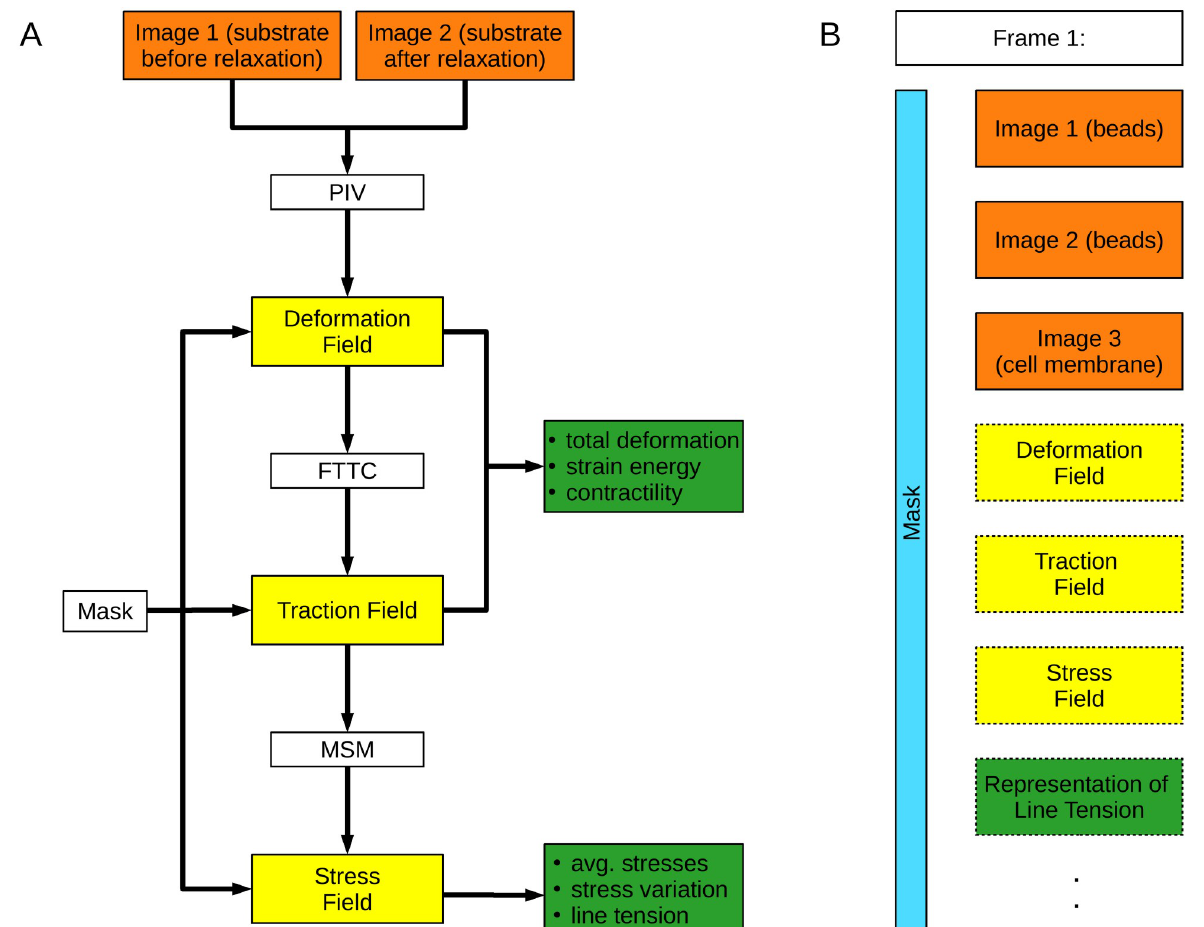
Fig 1. Workflow of pyTFM and image database organization. A: Workflow of TFM and Monolayer Stress Microscopy analysis with pyTFM. B: Organization of the pyTFM ClickPoints database. Input images are colored in orange, intermediary results in yellow, and the final output in the form of scalar measures in green. The mask that defines the cell boundaries and the area over which strain energy, contractility and monolayer stresses are computed is colored light blue.